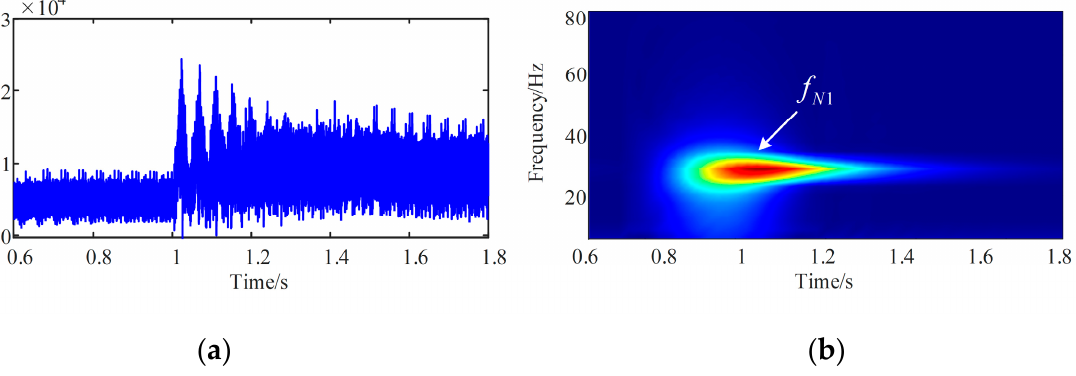
Figure 16. Motor 1 speed: ( a ) time domain; ( b ) time-frequency domain (0–80 Hz).